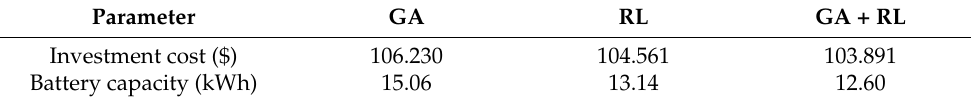
Table 2. A performance comparison of GA RL with standalone GA and RL algorithms [68].